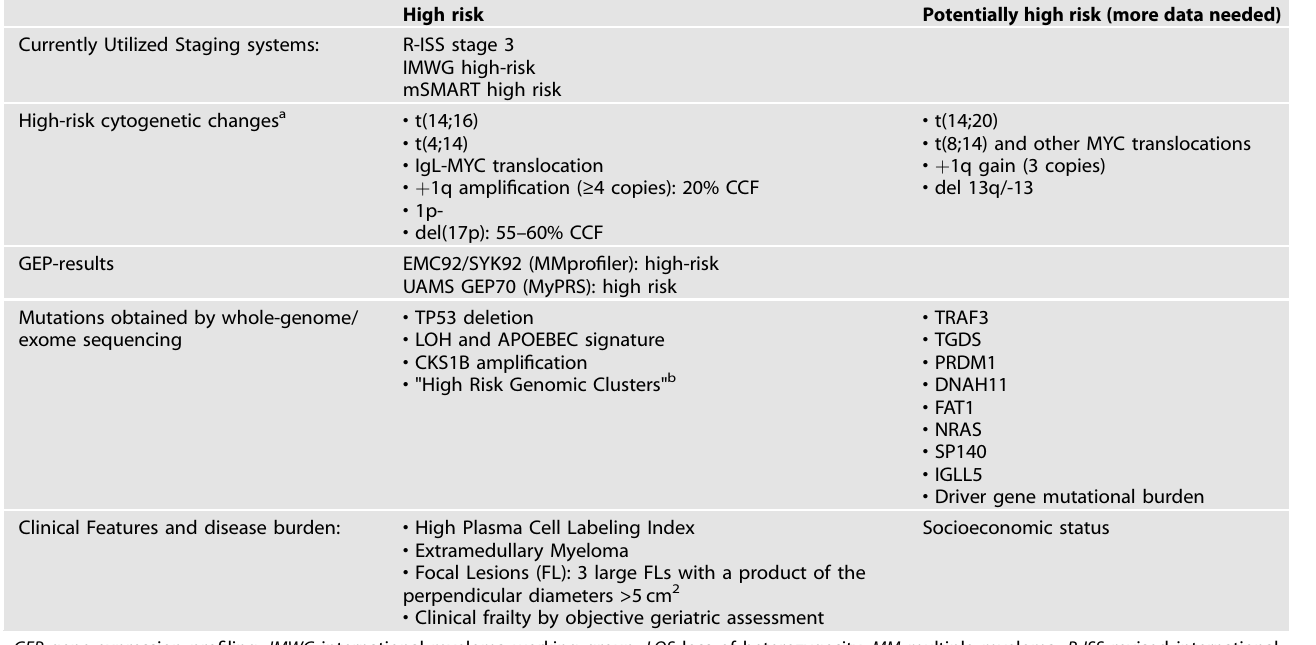
Table 5. High-risk features for newly diagnosed multiple